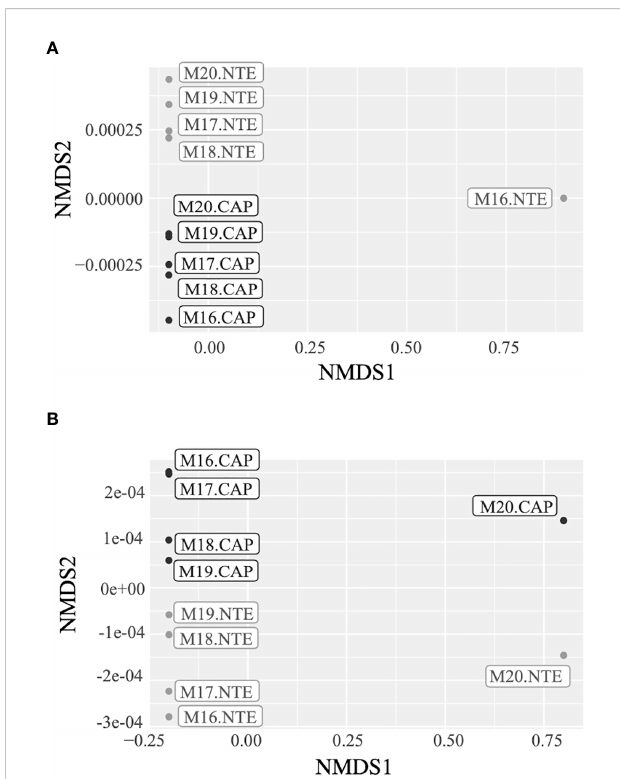
FIGURE 3 NMDS plots representing the differences between (A) the bacterial communities ’ structure and (B) the archaeal communities ’ structure of Capelinhos (black) and North Tour Eiffel (grey) sites.